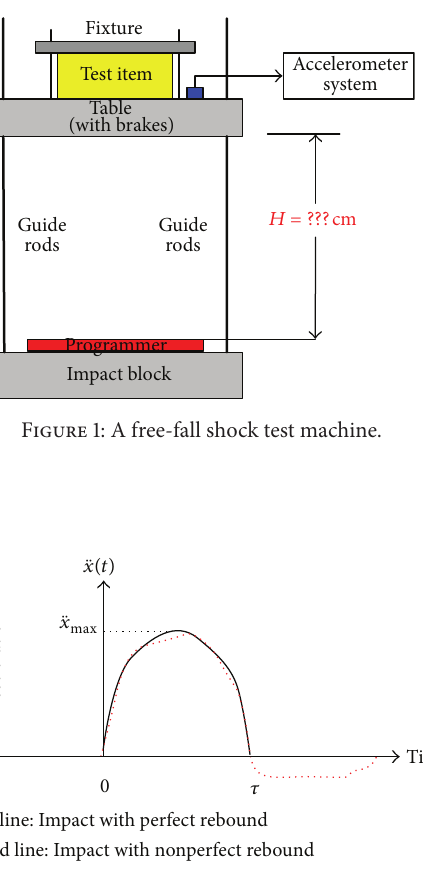
Figure 2: The waveform of a half-sine shock.